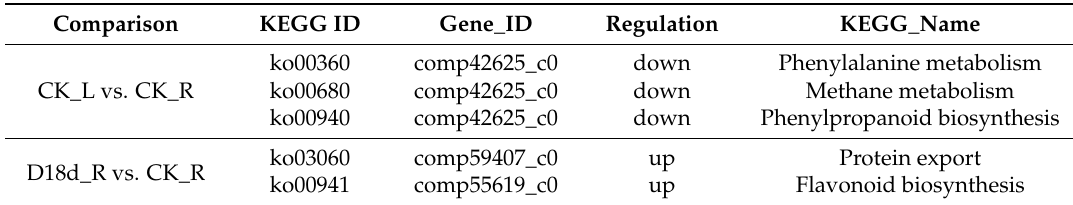
Table 2. KEGG annotation of correlation